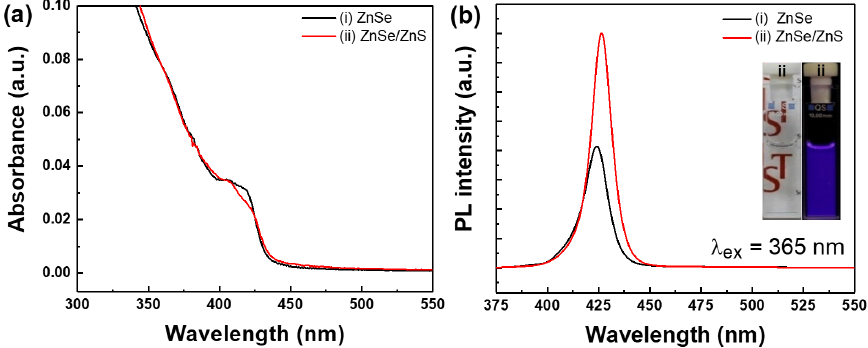
Figure 2. ( a ) Absorption and ( b ) PL spectra of (i) ZnSe C QDs and (ii) ZnSe/ZnS C/S QDs synthesized at 310 °C. The inset in ( b ) shows photographs of the ZnSe/ZnS C/S QD solution under indoor light (left) and UV light (right, λ = 365 nm).